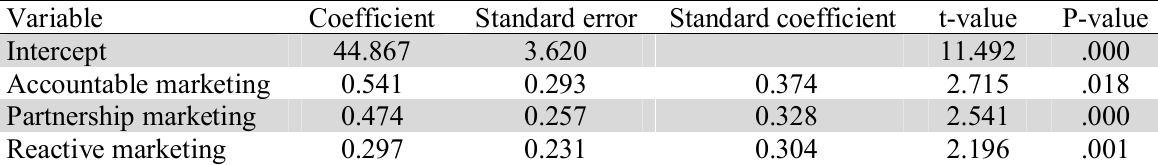
The summary of stepwise regression